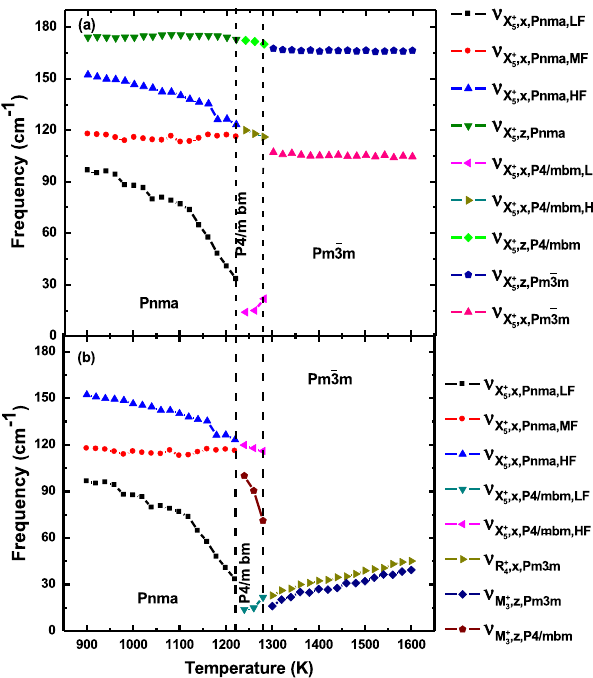
Fig. 5 Temperature dependence of natural frequencies of some phonon modes that have antipolar cation character a and/or oxygen octahedral tiltings character b . The vertical dashed lines delimit the different phases obtained in the calculations for our BFO system subject to hydrostatic pressure. See text for the notations on this fi